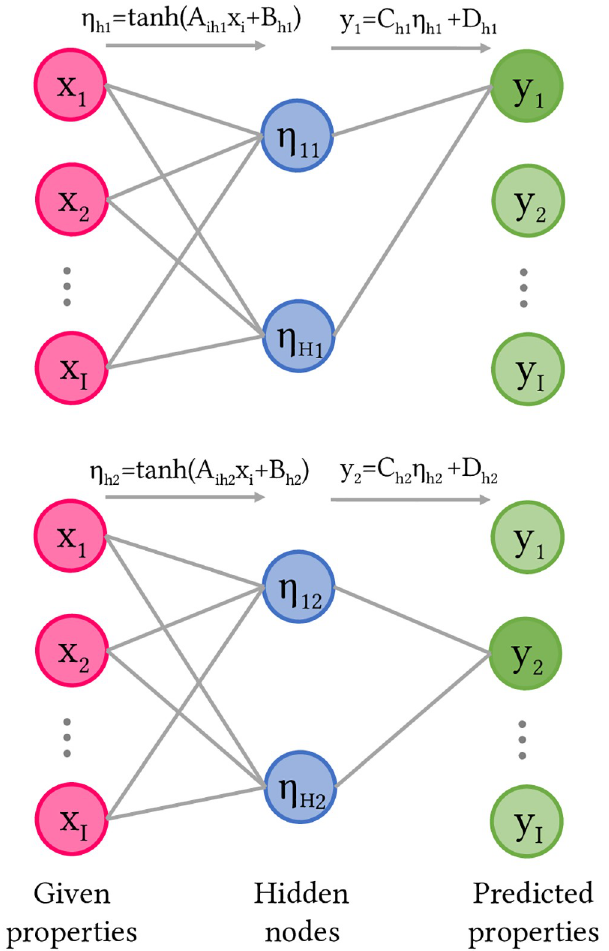
Fig 1. Neural network to model data. The graph illustrates how different inputs x i are used to calculate the outputs for y 1 (top) and y 2 (bottom); similar graphs can be drawn for all other y j to compute all the predicted properties. Linear combinations (grey lines) of the given properties (red) are taken by the hidden nodes (blue) through a non-linear tanh operation is applied, and a linear combination (grey lines) of the hidden nodes returns the predicted property (green).